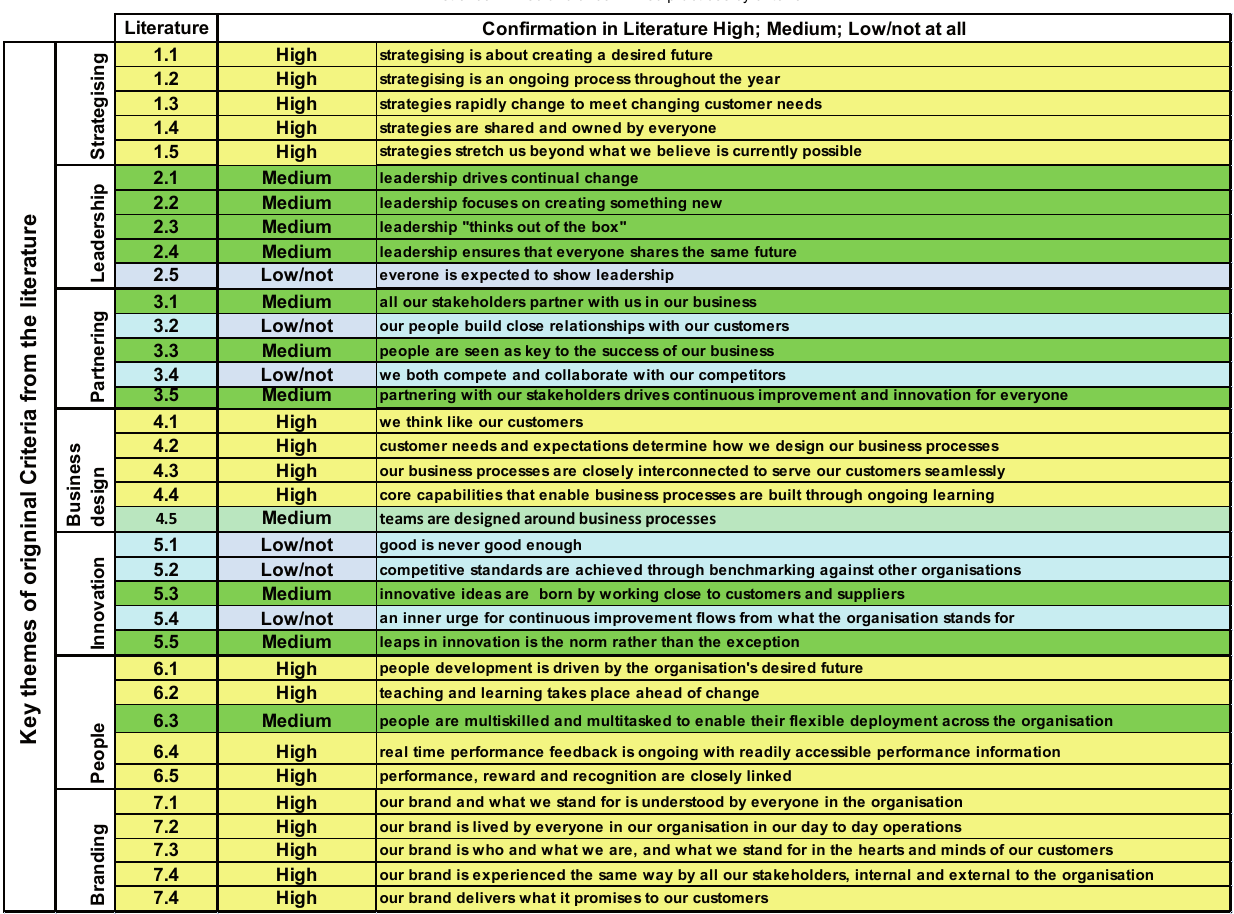
TABLE 8 List of confirmed and unconfirmed practices by